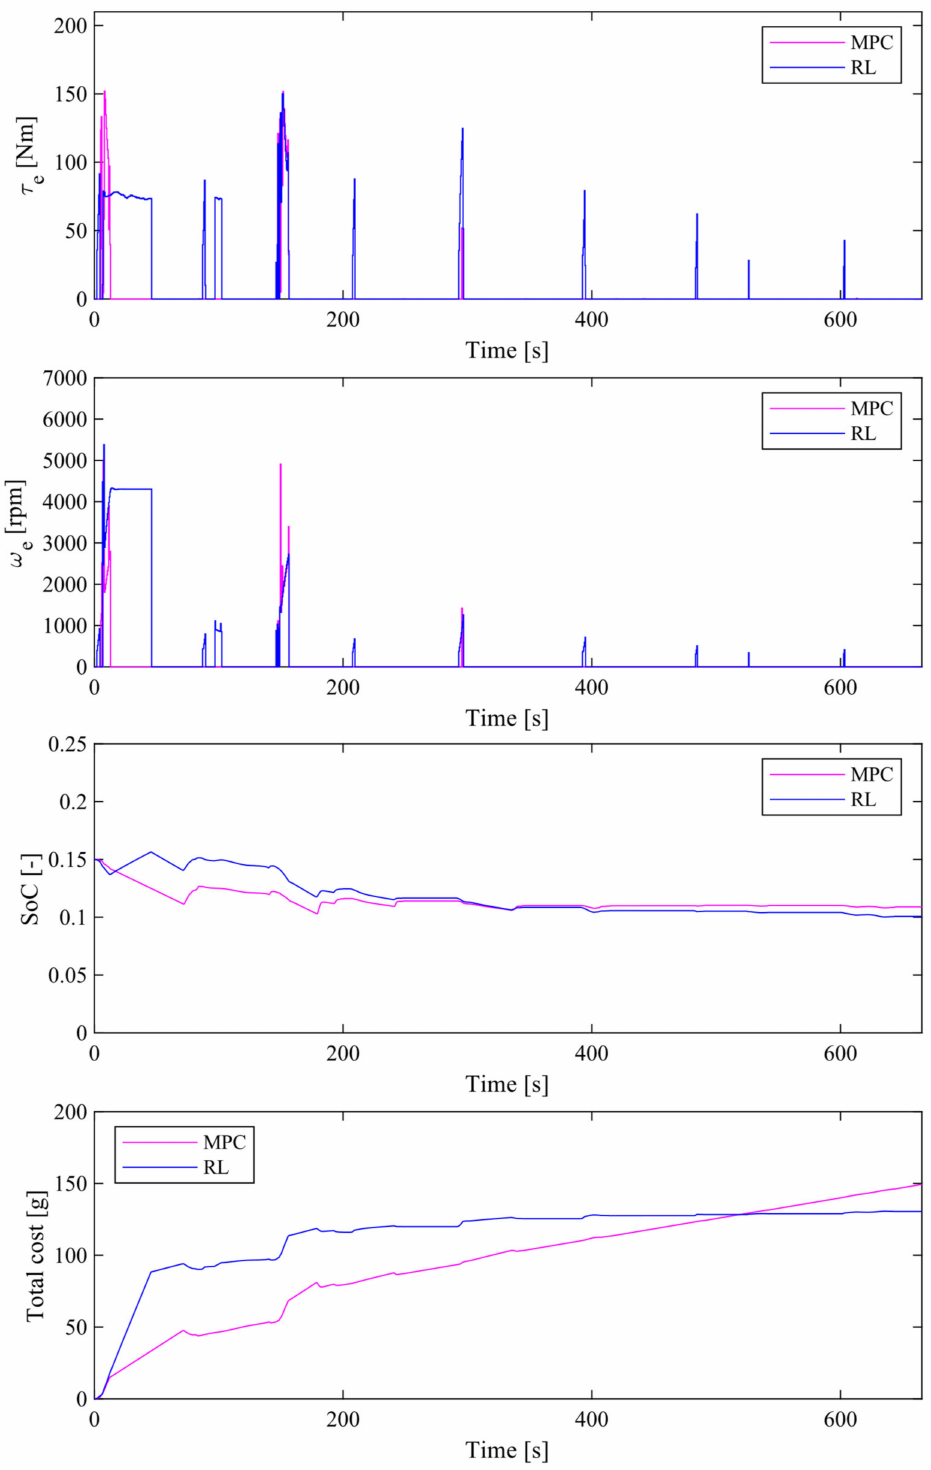
Figure 14. Simulation results of the proposed method and the MPC method for the test data on Road B (engine torque, engine speed, SoC , and total